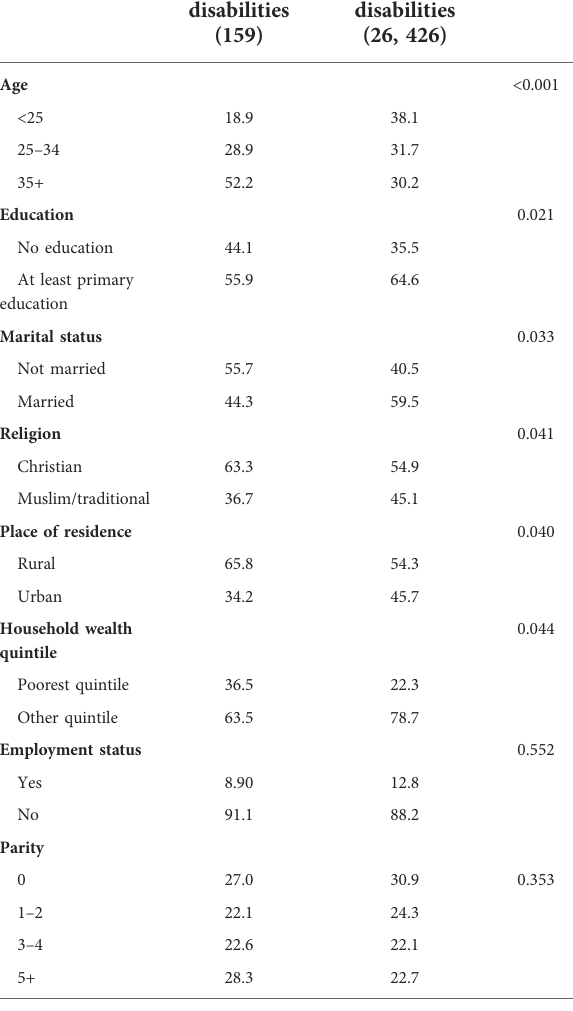
TABLE 1 Demographic characteristics by disability status.